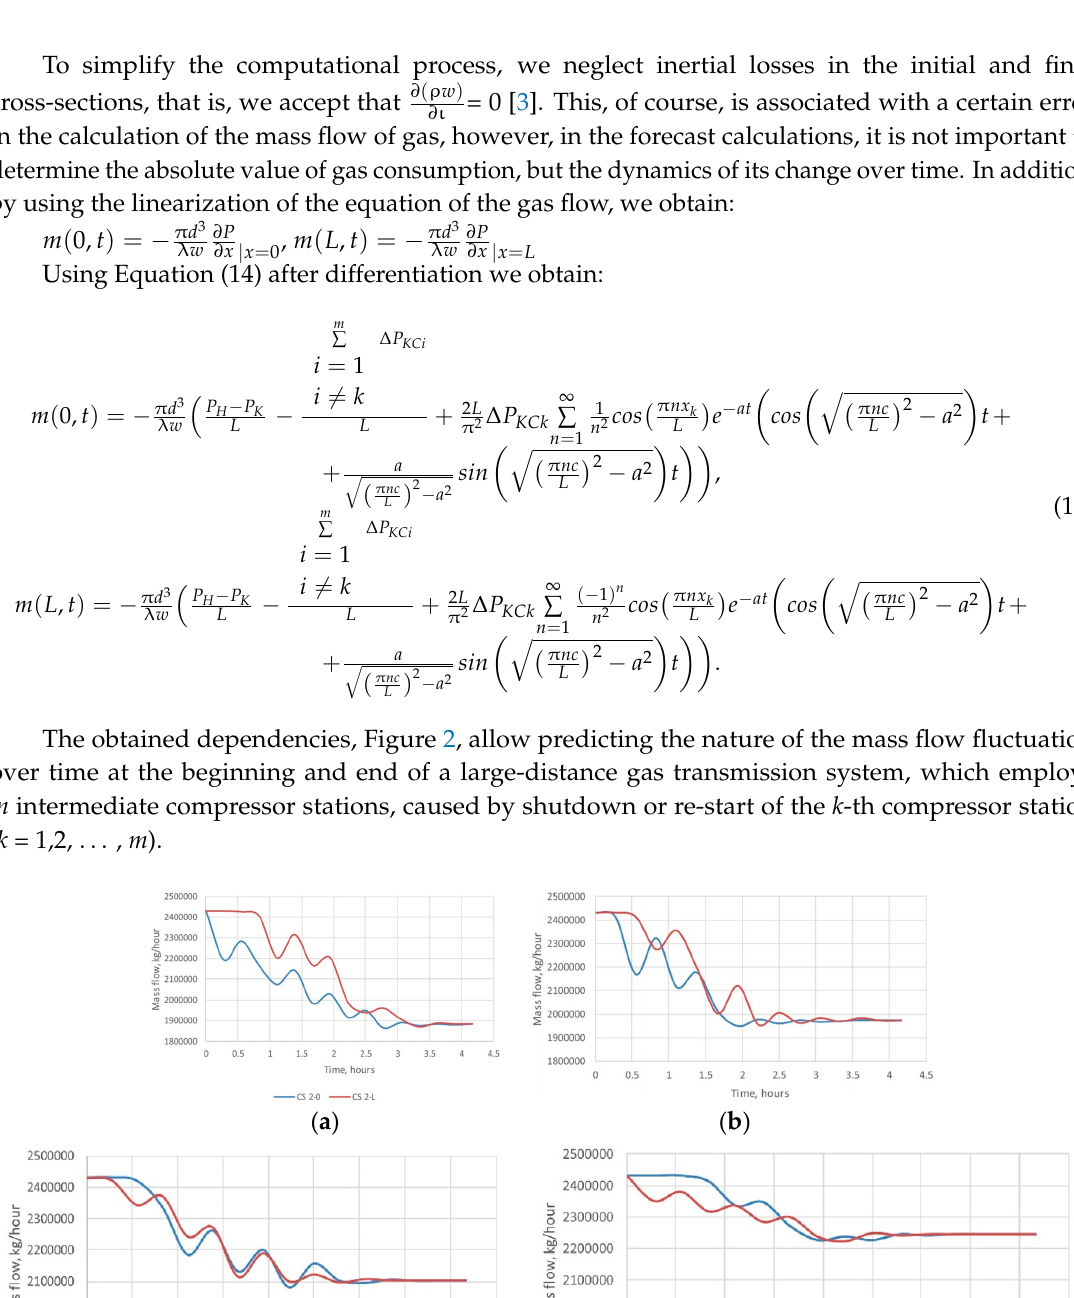
(b) Figure 3. Structure of the system of gas mains and branches of Ukrtransgas PJSC (ths. km and %) in terms of the period of operation (a) and diameters (b). Increasing the reliability of operation of gas mains, which have been in service for more than 30 years, is only possible taking into account the specific features of their laying, and optimization of